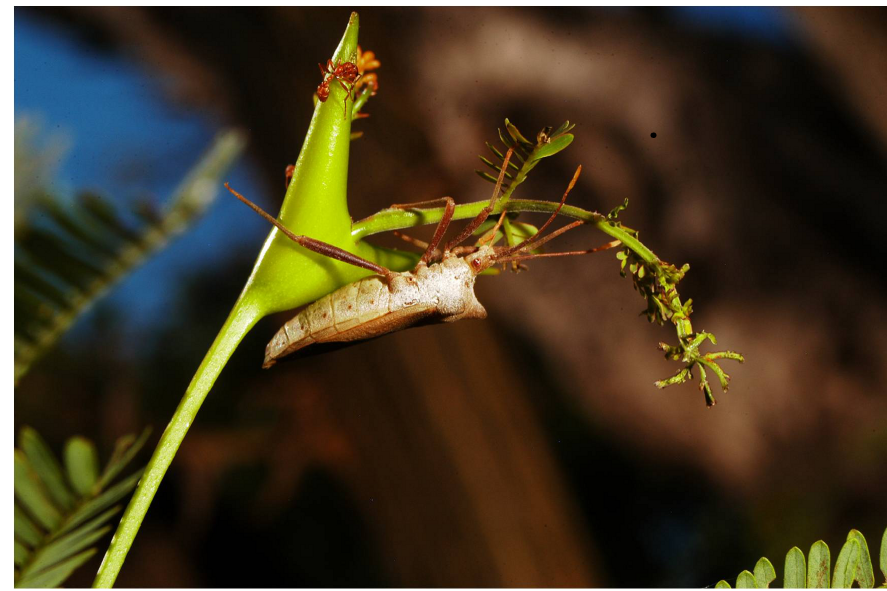
Figure 1. Piezogasterreclusus feeding on a Vachelliacollinsii tree occupied by Pseudomyrmexspinicola ants. Photo by: Andre´ Kessler